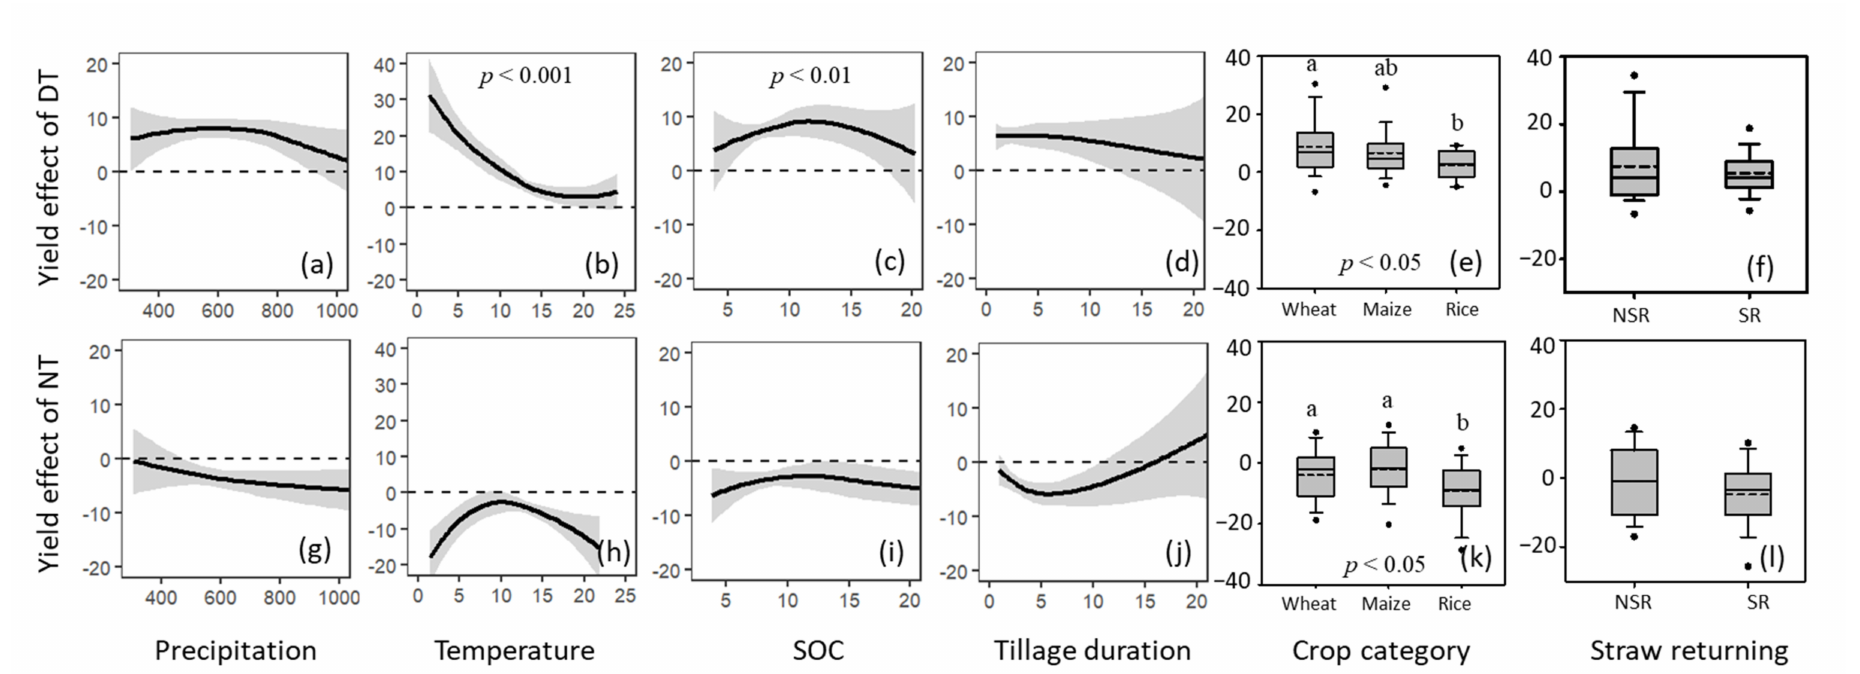
Figure 2. Relative yield percentage changes in DT and NT compared with RT management plans, dependent on climatic conditions (( a , g ), annual mean precipitation; ( b , h ), annual average temperature), soil properties (( c , i ), soil organic carbon (SOC)) and experimental conditions (( d , j ), tillage duration; ( e , k ), crop category; ( f , l ), SR). ( a – f ) are for DT practice; ( g – l ) are for NT practice. Shaded bands indicate 95% confidence intervals. p < 0.001, 0.01, 0.05 indicate significant correlation between tillage-induced yield effects. Different letters for crop category ( e , k ) indicate significant difference between treatments at p < 0.05. SR, straw returning; NSR, no straw returning; DT, deep tillage; NT, no tillage; RT, rotary